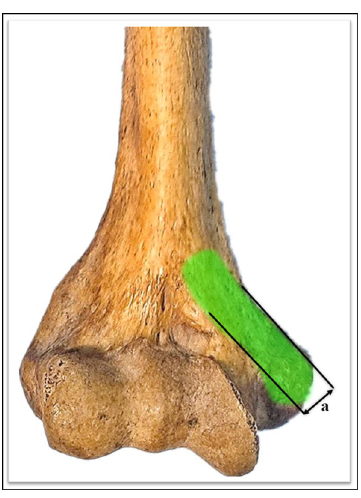
Fig. 2 This figure shows the distance from the medial condyle to the base of the coronal fossa ( a ). The green area represents the single-cortical fixation area for screws in the medial epicondyle region of the humerus